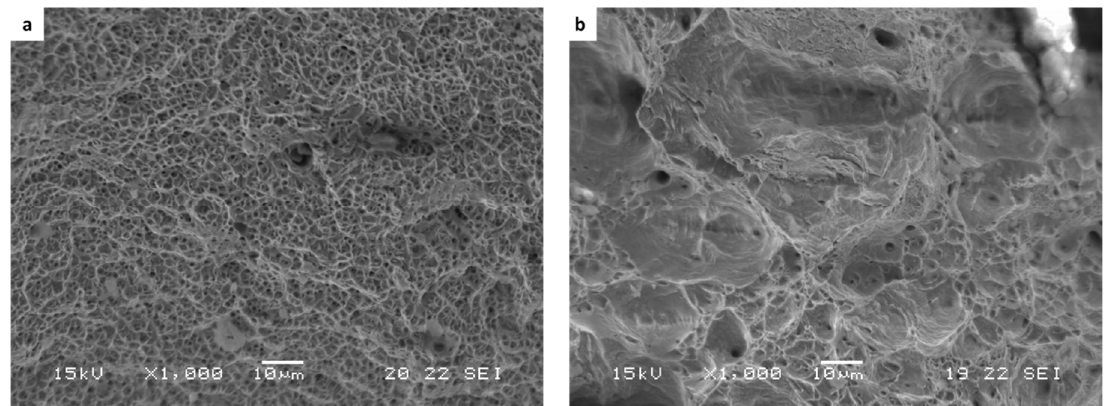
Figure 12. Fracture surface analysis obtained after SSRT examination at a strain rate of 2.5 × 10 − 7 1/s: ( a ) WLAM sample and ( b ) counterpart AISI 316L alloy.